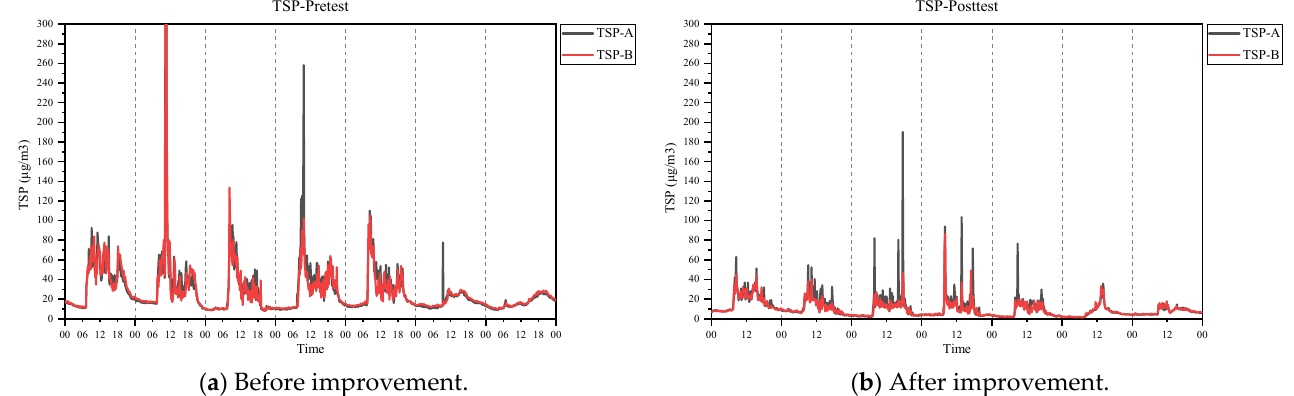
Figure 8. Comparison of indoor TSPs before and after the implementation of the improvement plan.